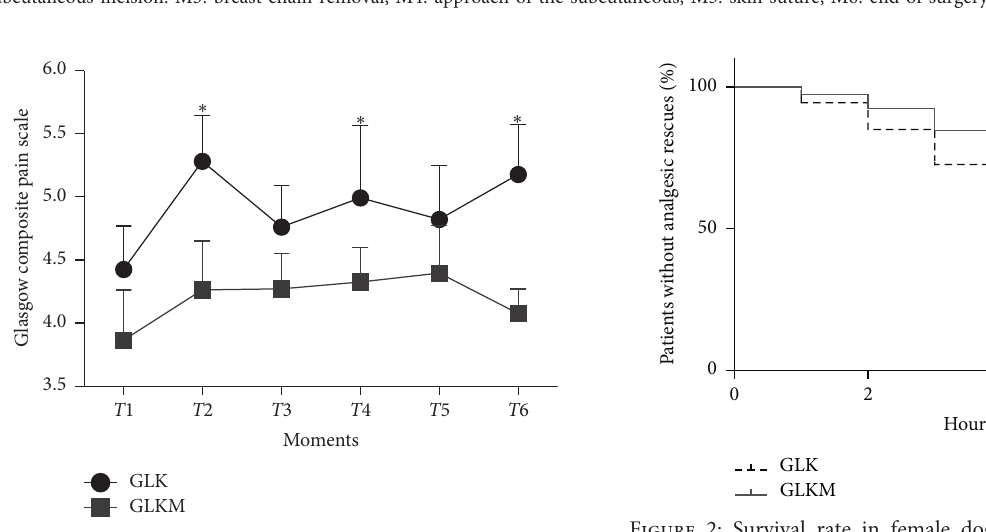
Figure 1: Mean ± standard error of the mean of the modified Glasgow composite scale for pain assessment in female dogs submitted to unilateral radical mastectomy, continuous infusion of lidocaine and ketamine (GLK), and continuous infusion of lido- caine, ketamine, and maropitant (GLKM) in the six moments of evaluation in the postoperative period ( P < 0.01).